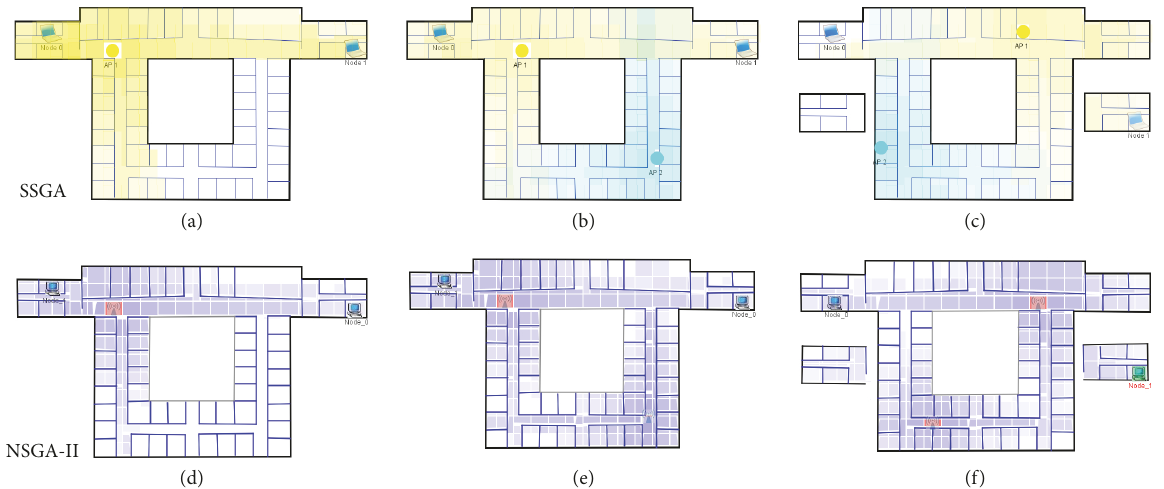
Figure 6: Comparison of solutions for SSGA and NSGA-II: (a)–(d) one AP for two nodes, (b)–(e) two APs for two nodes, and (c)–(f) two APs in two